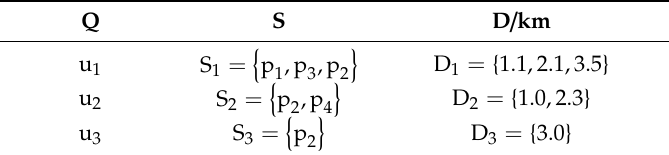
Table 2. Example of the nearest neighbor sets at the end of the search